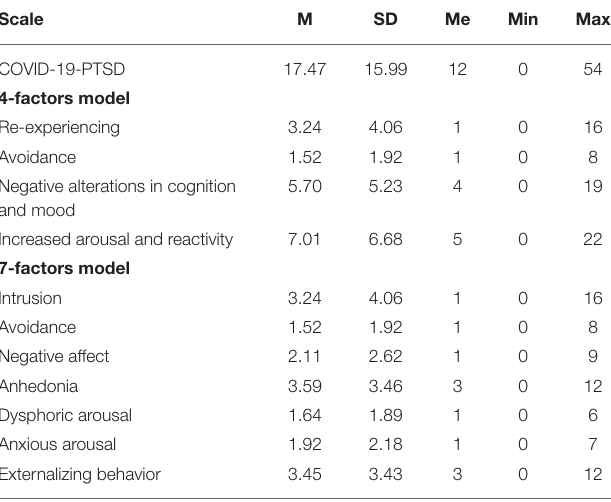
Frontiers in Psychiatry |